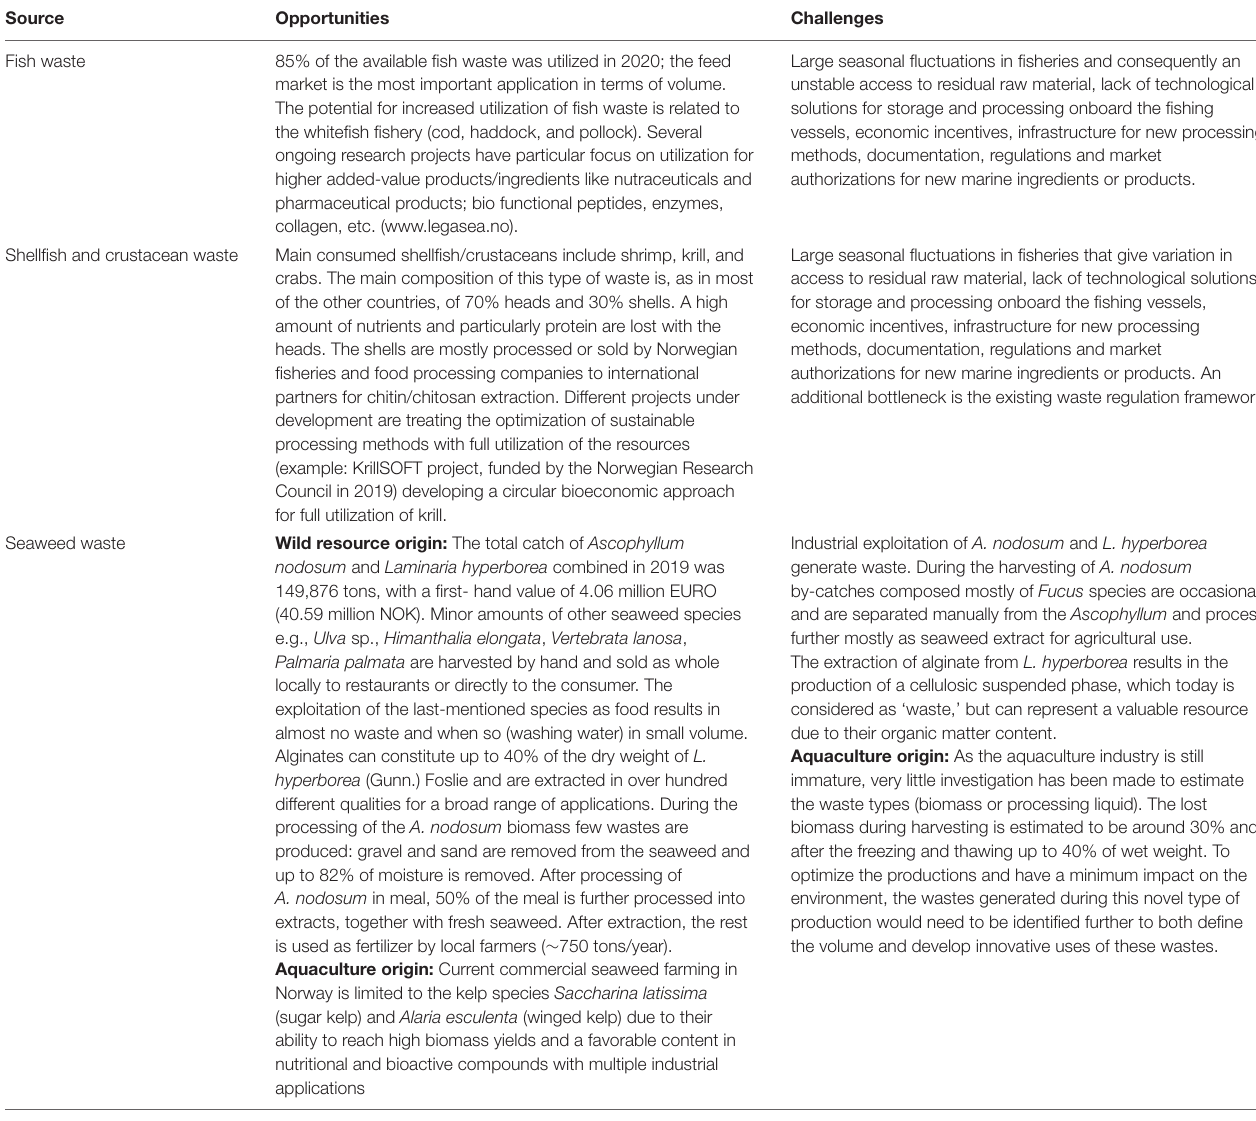
TABLE 5 | Summary of marine waste utilization in